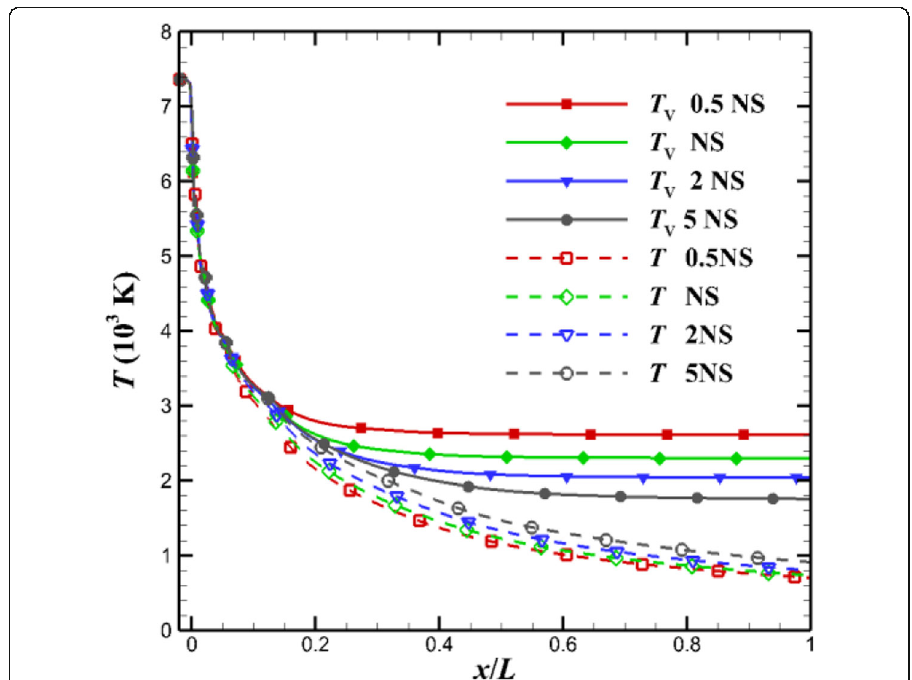
Fig. 5 Comparison of the centerline temperature distribution based on the HEG